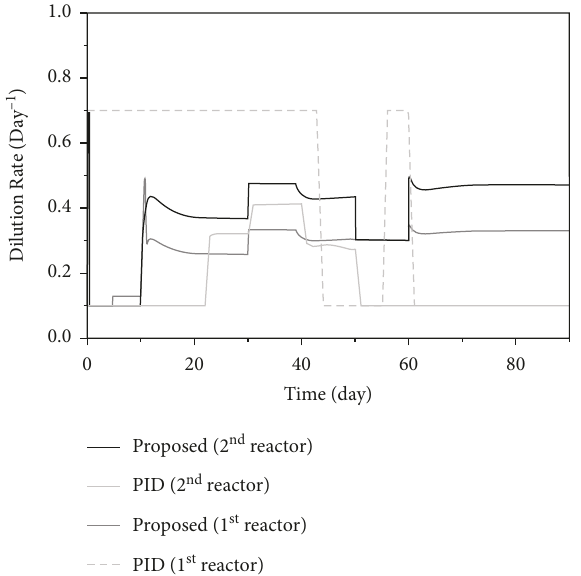
Figure 13: Dilution rate profiles corresponding to Figure